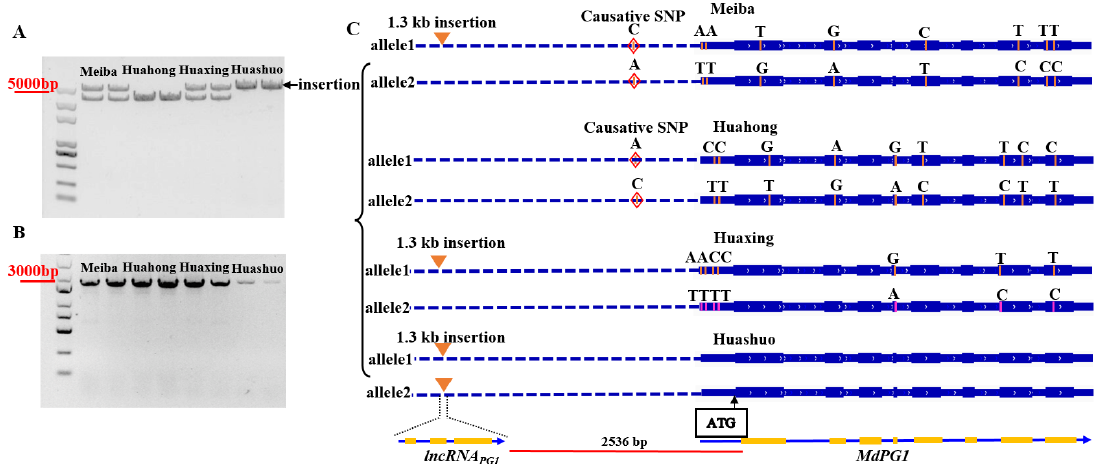
Figure 1. Genetic variants of MdPG1 alleles in four apple cultivars. ( A , B ) DNA fragments covering the promoter ( A ) and coding regions ( B ) in “Meiba”, “Huahong”, “Huaxing”, and “Huashuo”. PCR analysis of the four cultivars detected a larger DNA fragment in three cultivars indicating DNA insertion in the MdPG1 promoter. The arrow indicates a 1.3 kb insertion in the larger fragment of the MdPG1 promoter region in “Meiba”, “Huaxing”, and “Huashuo”. ( C ) The SNPs and lncRNA PG1 were phased into allele 1 and allele 2 after genomic PCR fragments covering the promoter and coding regions of the two alleles of MdPG1 were cloned and fully sequenced. The triangle represents a 1.3 kb insertion ( lncRNA PG1 ) at 2356 bp upstream of the ATG start codon. The diamond represents an ERF-binding element, and the causative SNP was within the ERF-binding element at 411 bp upstream of the ATG start codon.